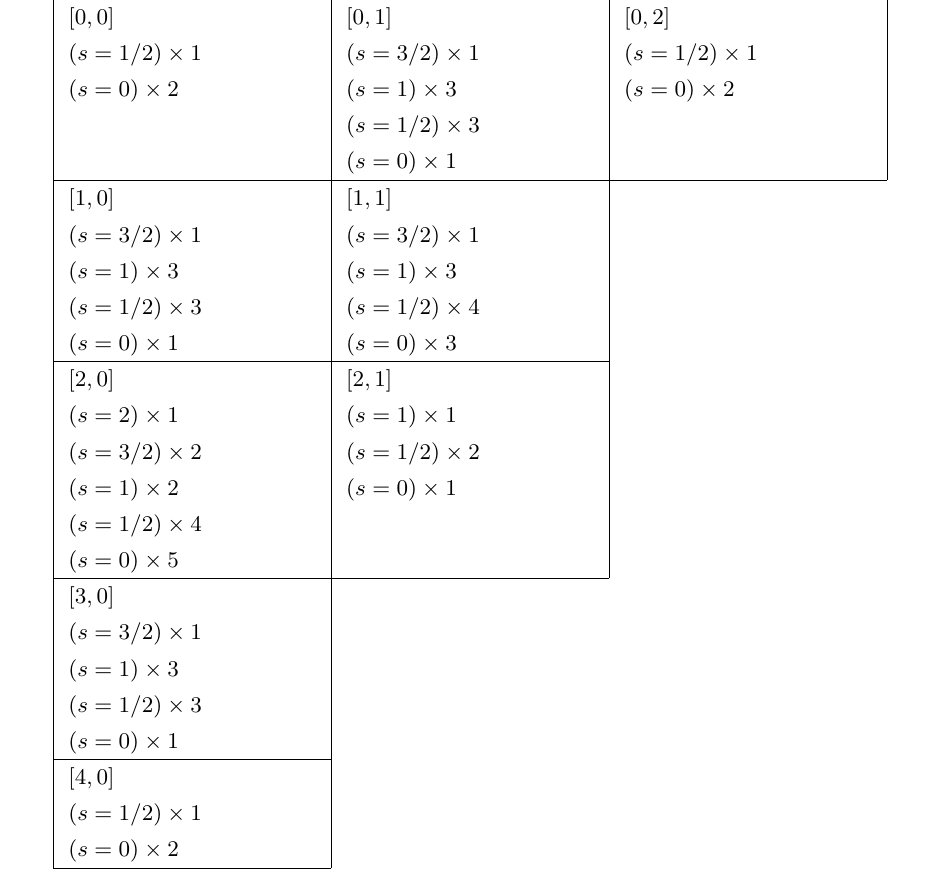
Table 20 . States at KK level n = 2 for the N = 0 G 2 -invariant AdS 4 solution of type